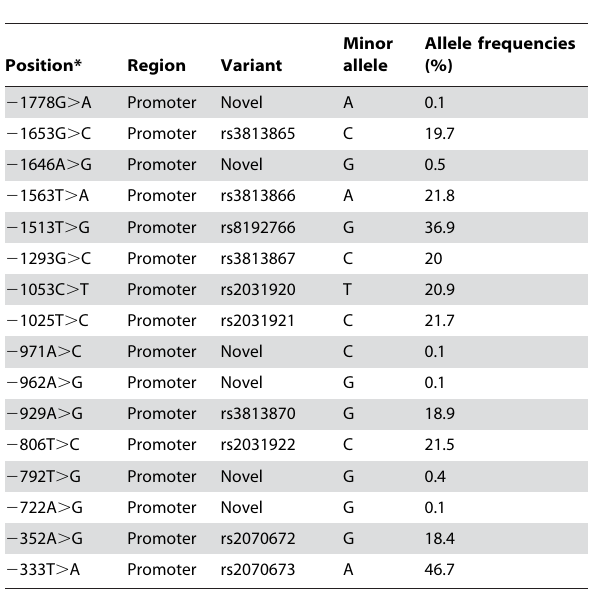
Table 1. 16 identified SNPs in the CYP2E1 promoter region and their frequencies in the Chinese Han population.